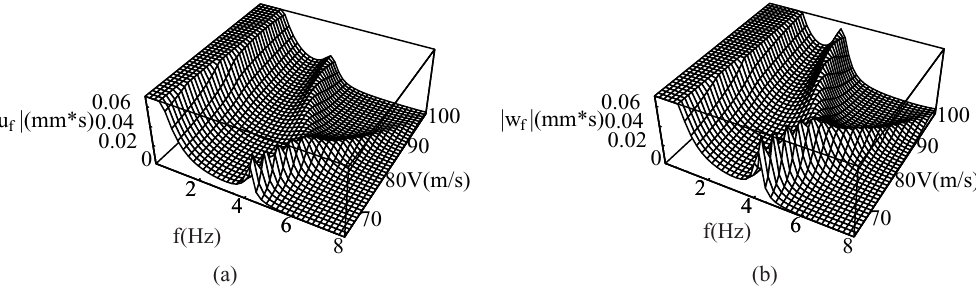
Fig. 7. The “zoomed” plots of the amplitude spectra for constant load and beam on a surface: (a) the horizontal component, (b) the vertical component.